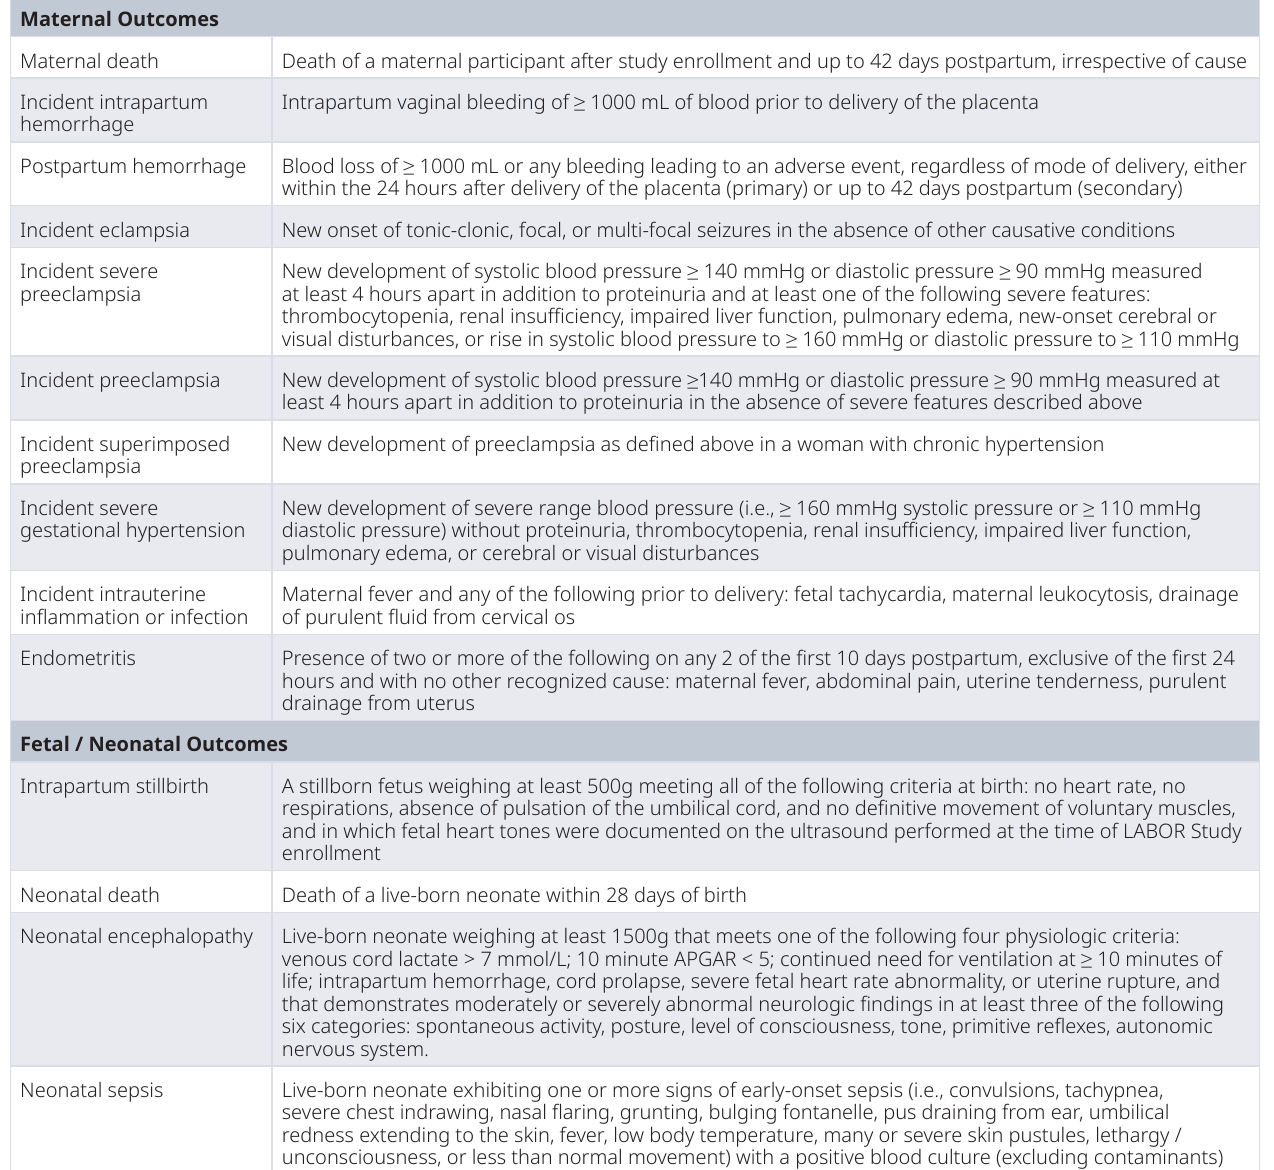
Table 2. Study outcome